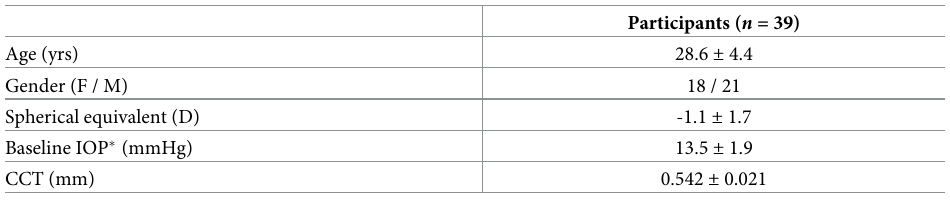
Table 1. Clinical characteristics of